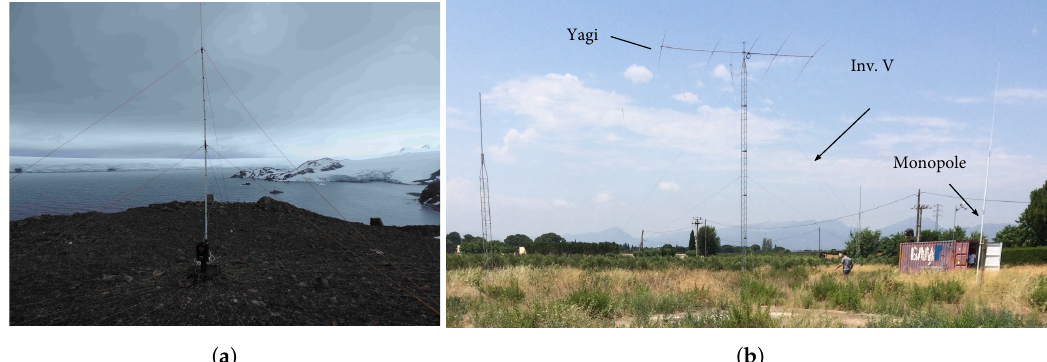
Figure 9. ( a ) The single transmitter antenna in Antarctica and ( b ) the three antennas of the receiver in Cambrils.